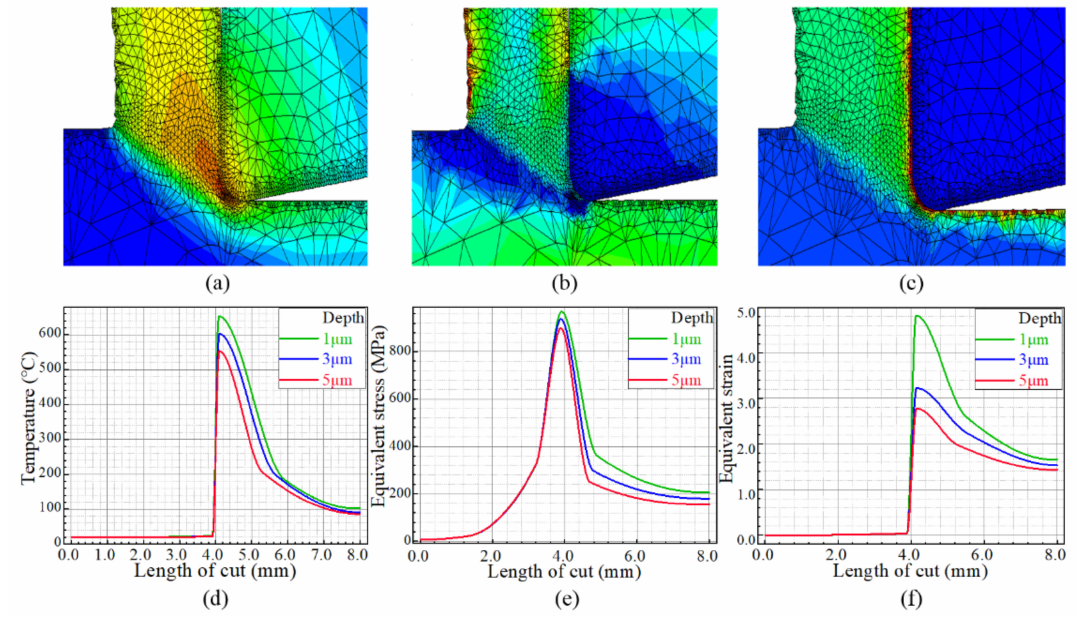
Figure 4. Temperature, strain and stress fields. ( a ) Temperature cloud map, ( b ) stress cloud map, ( c ) strain cloud map, ( d ) subsurface temperature variation, ( e ) subsurface stress variation, ( f ) subsur- face strain variation.